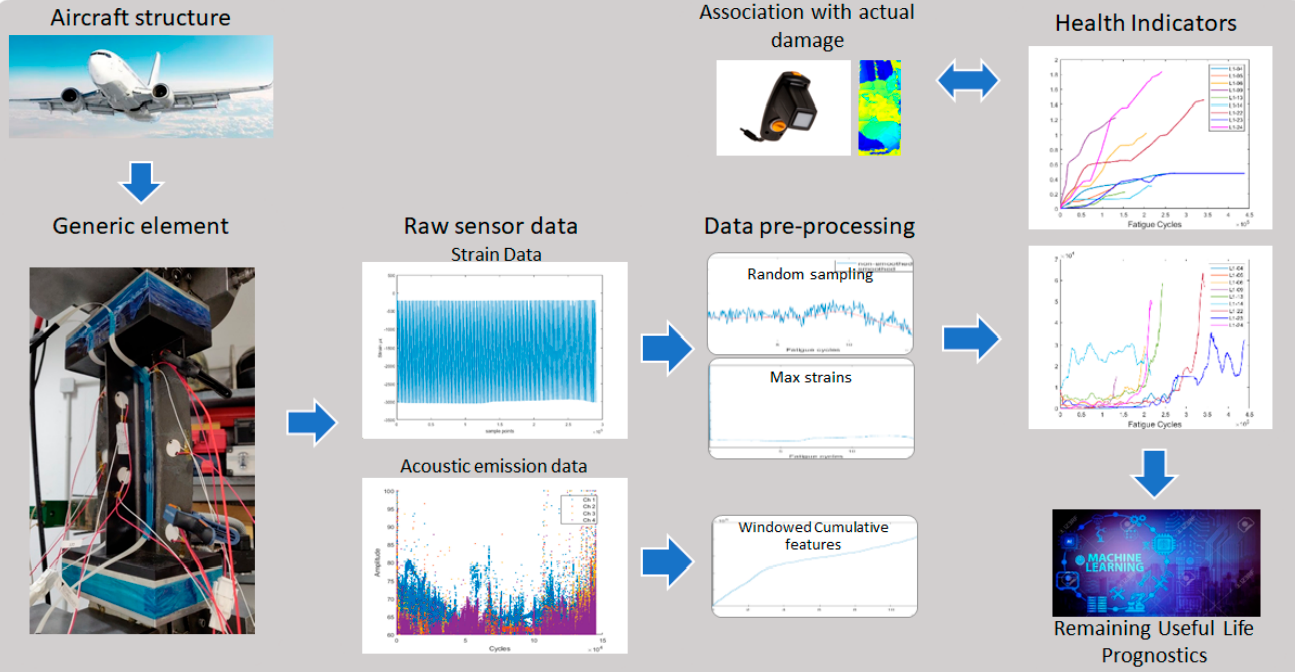
Figure 1. Schematic representation of the proposed methodology.